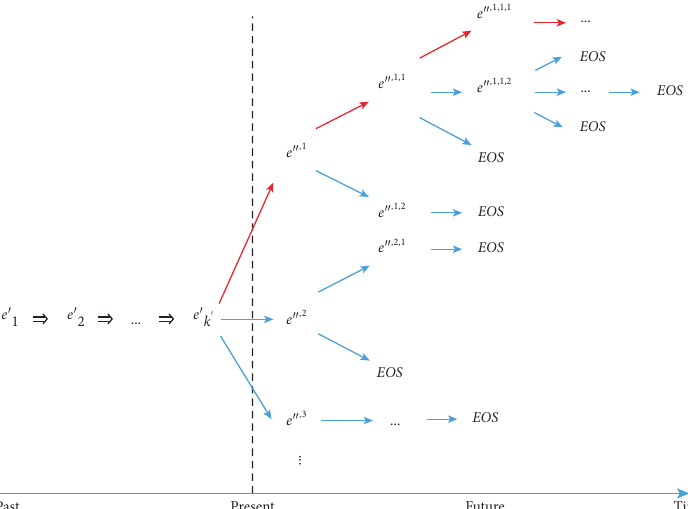
Figure 1: The predicted scenarios ordered in a tree structure (the EOS tag indicates the end-of-sequence